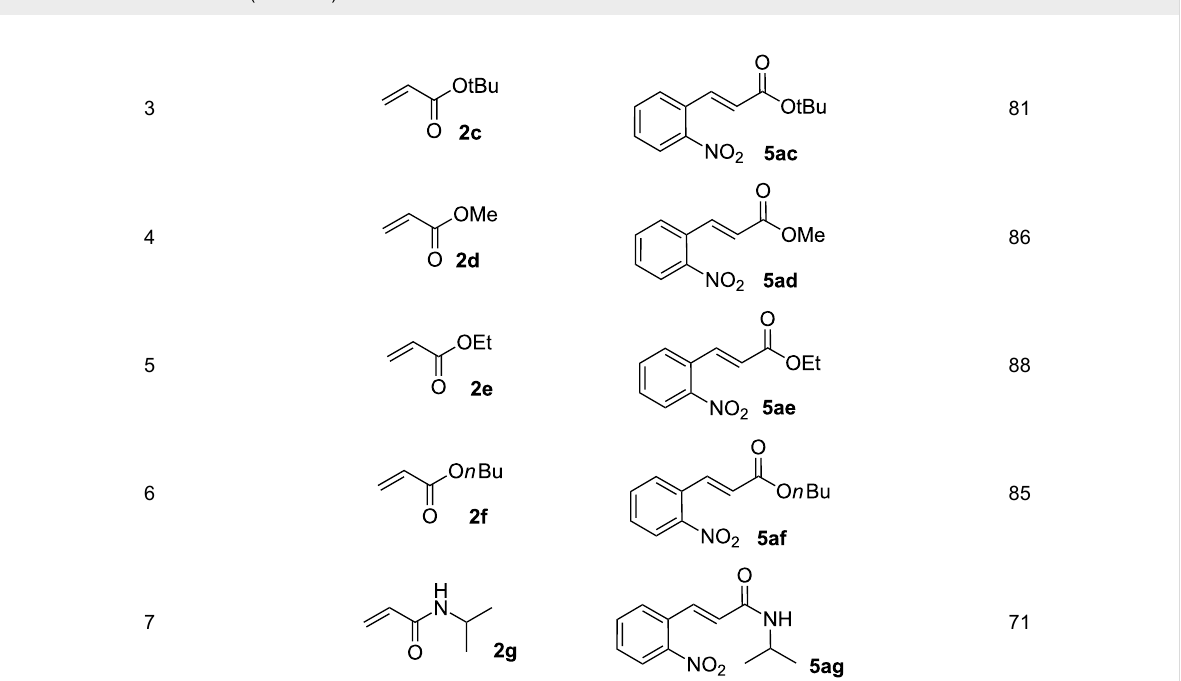
Table 2: Variation of the olefin. (continued)